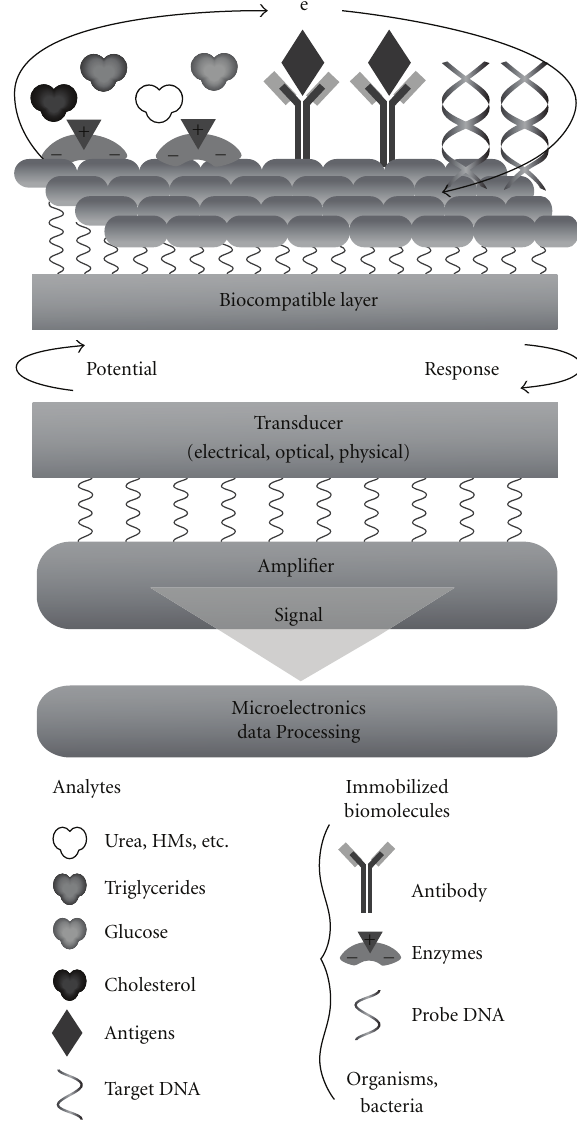
Figure 1: Schematic principle of operation of a